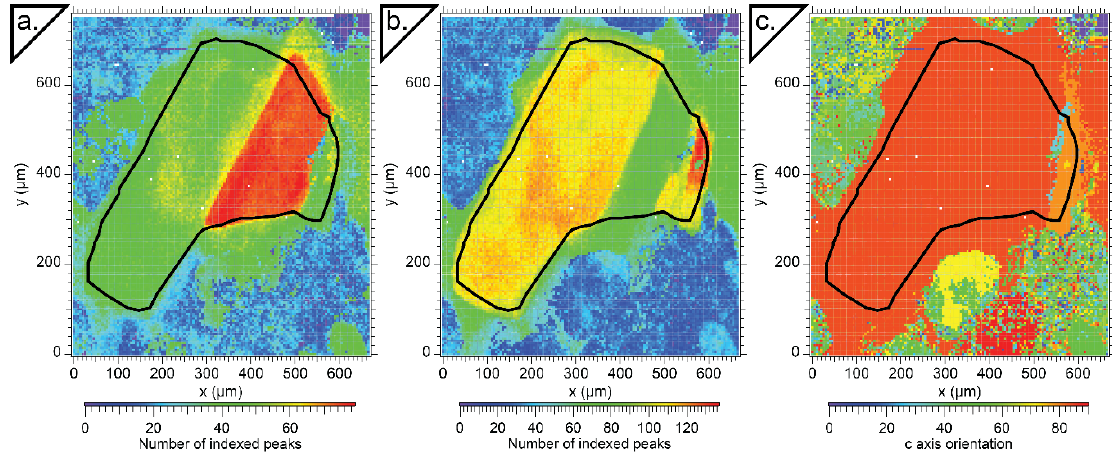
Figure 9. The SiC3 grain indexed as ( a ). 6H-SiC and ( b ). 4H-SiC. ( c ). The c-axis orientation with respect to the sample normal shows several different orientations are present in this sample. The black outline indicates the surface expression of the sample, based on microscopy images.